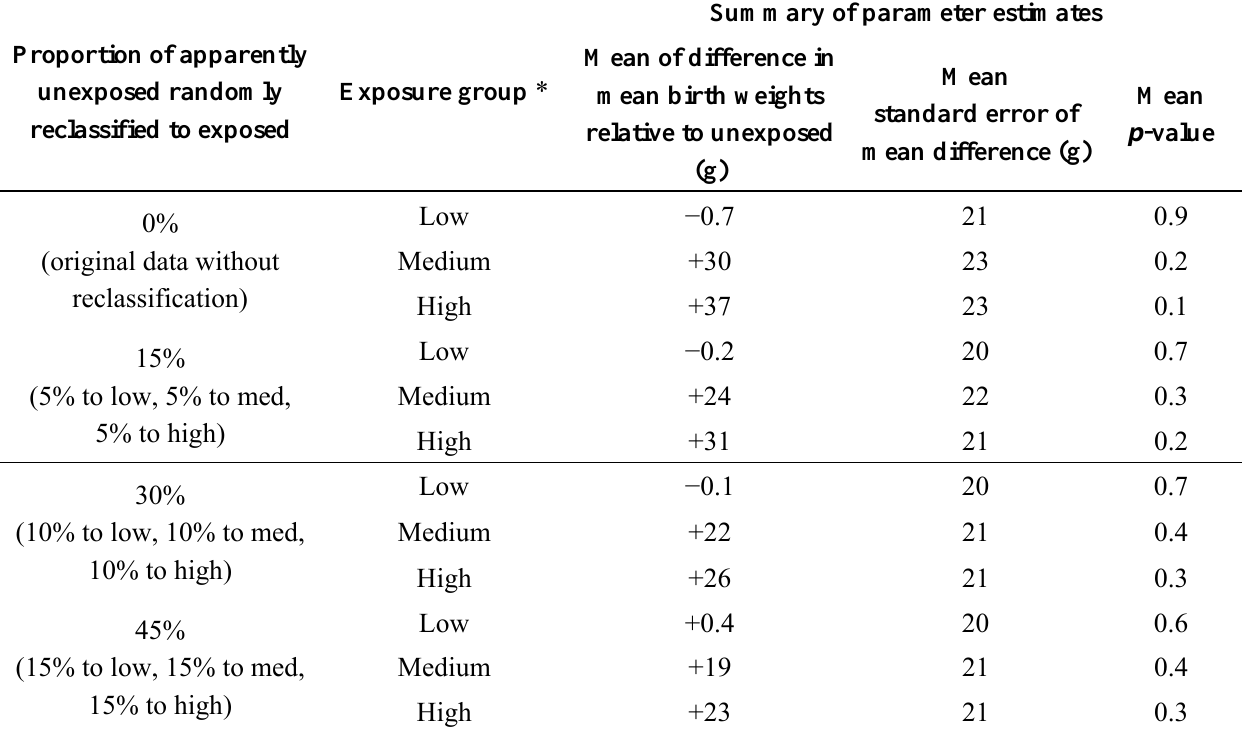
Table 9. Repeated random reclassification (1,000) of self-reported unexposed group to various exposure levels: Means of adjusted differences in mean birth weights with SHS exposure after repeated